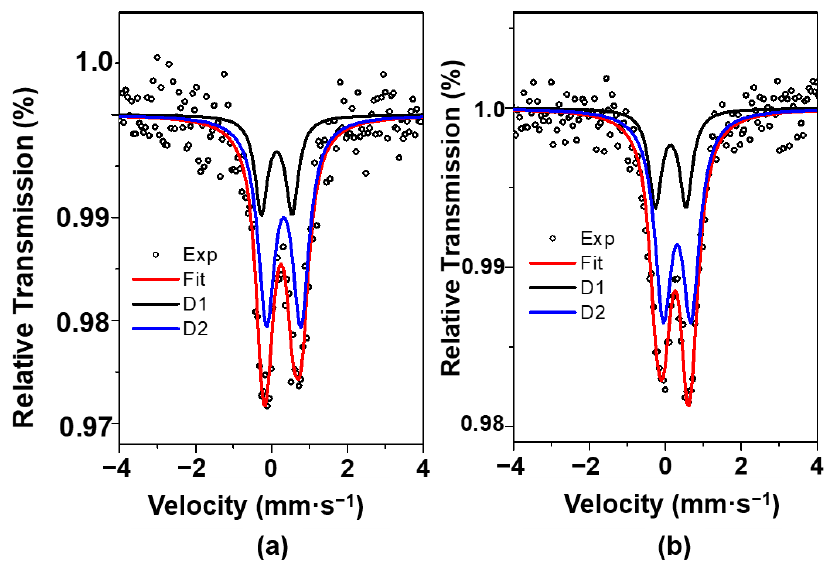
Figure 3. Mössbauer spectra of Fe x /SBA-15 samples: ( a ) Fe 6/ SBA-15 and ( b ) Fe 10 /SBA-15.